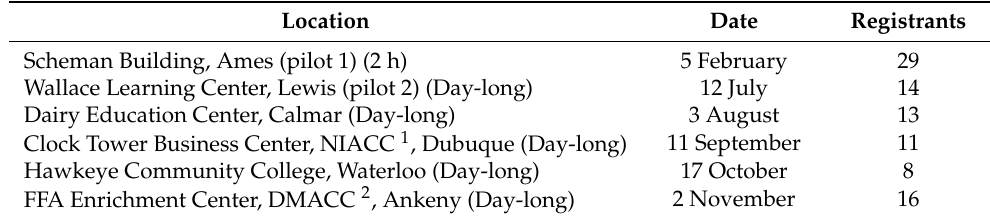
Table 1. Workshop locations in Iowa, length, date in 2018, and number of attendees. Location